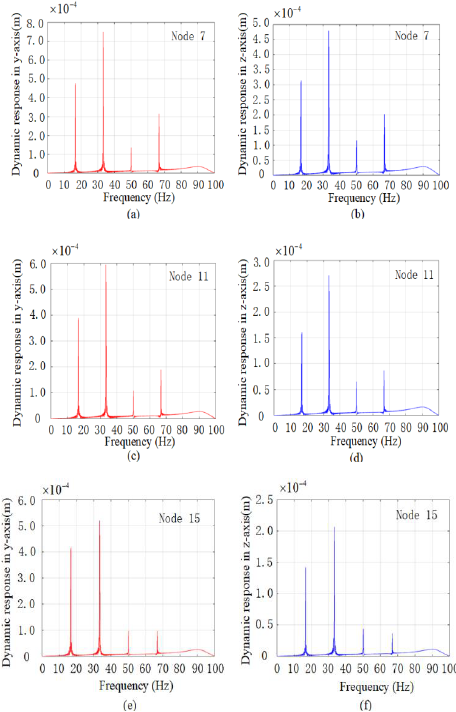
Figure 14. The mathematical simulated dynamic response with 0.8 mm parallel misalignment and 0.5 ◦ angular misalignment of nodes 7, 11, and 15 in the y -axis and z -axis. ( a ) Node 7 in the y -axis. ( b ) Node 7 in the z -axis. ( c ) Node 11 in the y -axis. ( d ) Node 11 in the y -axis. ( e ) Node 15 in the y -axis. ( f ) Node 15 in the z -axis.